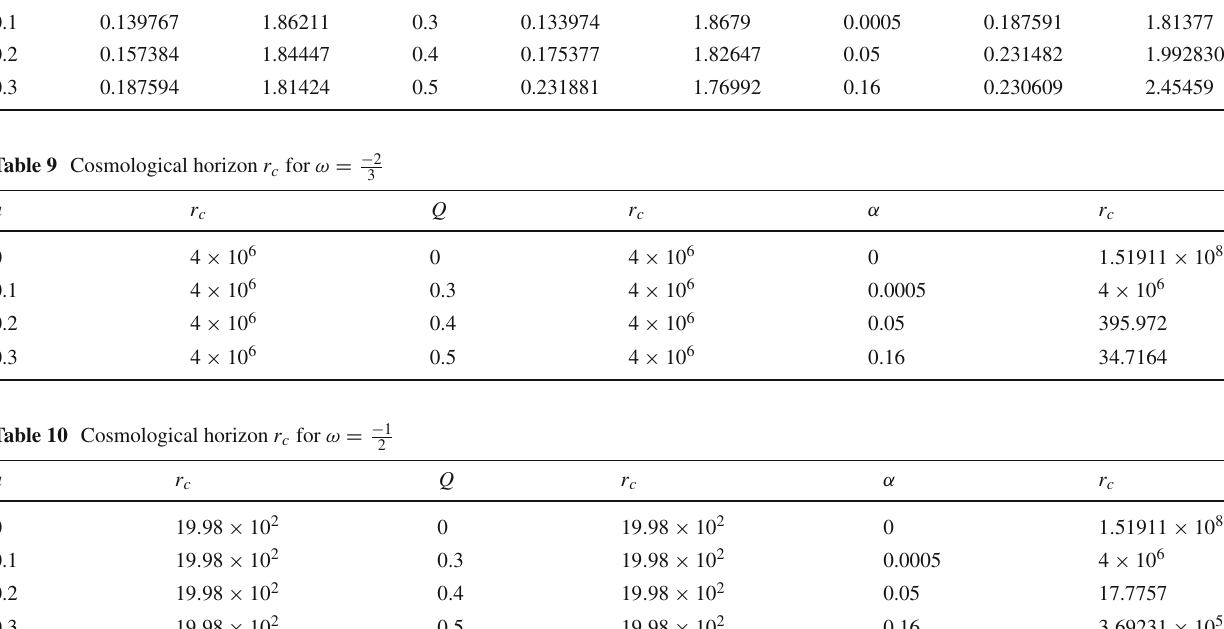
Table 8 Inner ( r h − ) and outer ( r h + ) horizons for ω = − 1